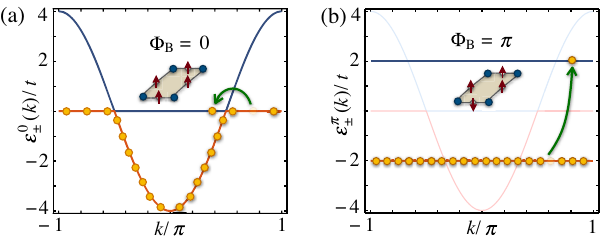
FIG. 2. Aharonov-Bohm instability. Band structure of the Creutz-Ising gauge theory for J ¼ h ¼ Δ ¼ 0 , and the corre- sponding filling of the fermionic sector. The green arrows depict the lowest-energy particle-hole excitations of the half-filled ladder. (a) For an Ising background with a vanishing flux Φ 0 , the ground state corresponds to a gapless state with B ¼ macroscopic degeneracy. (b) For Φ B ¼ π , there is destructive Aharonov-Bohm interference that opens a gap, forming two flat bands and lowering the ground-state energy (the semitransparent lines serve to compare to the Φ B ¼ 0